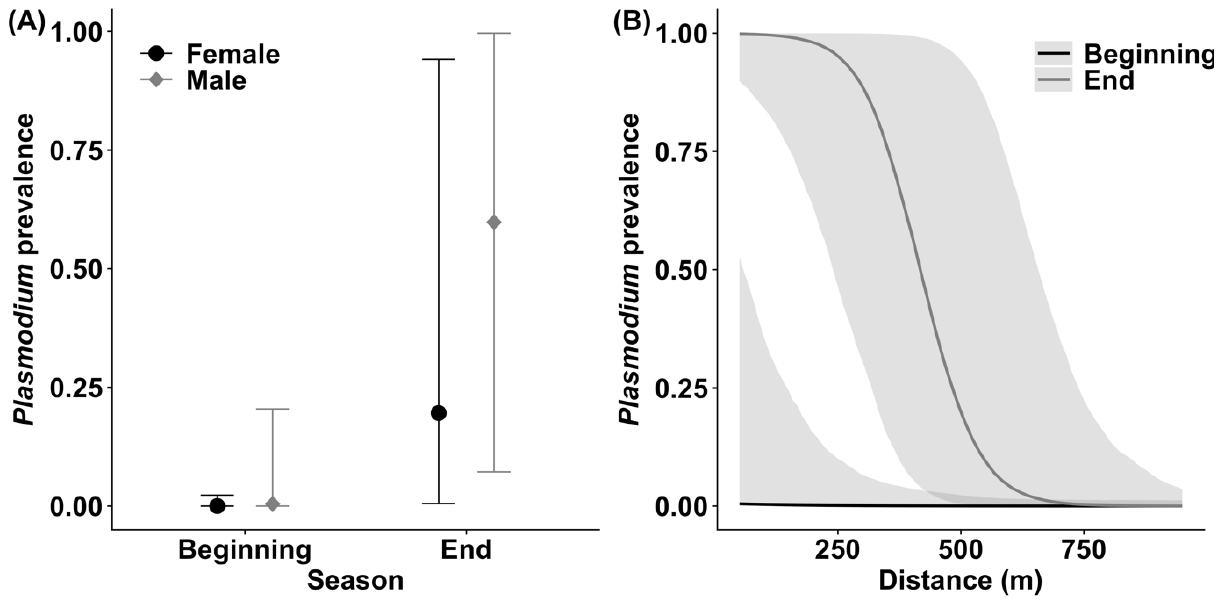
Figure 3. ( A ) Plasmodium prevalence in the blood of male and female Pied Flycatchers at the beginning and the end of the breeding season. Error bars represent 95% credibility intervals. ( B ) The relationship between the distance from the nearest water bodies and Plasmodium prevalence at the beginning and end of the breeding season. Solid lines show the estimated trendlines by the model, and grey-shaded areas represent 95% credibility